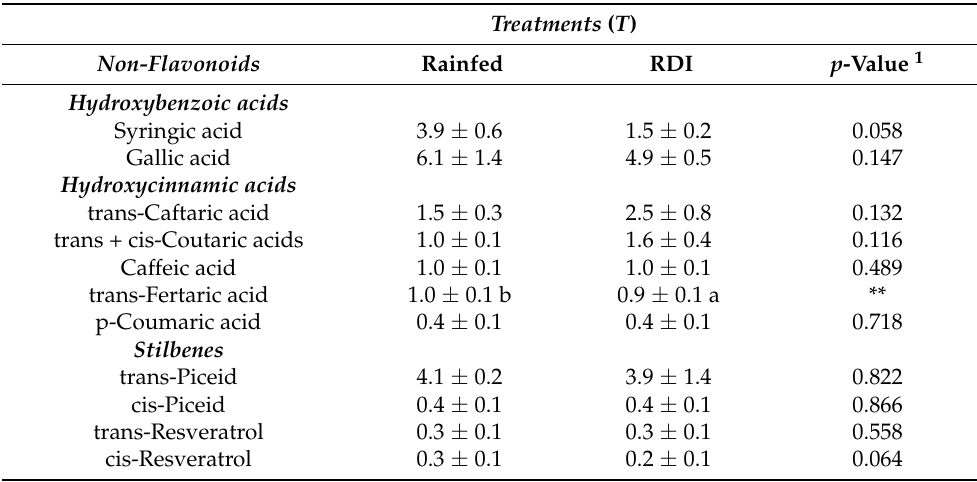
Table 4. Non-flavonoid content (mg/kg) in Monastrell grapes from grapevines under non-irrigated (rainfed) and regulated deficit irrigation (RDI)